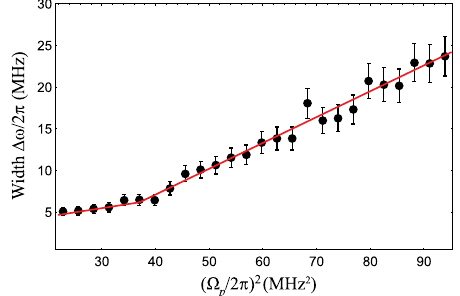
FIG. 9. Width of EIT transmission window vs Ω 2 same data set as in Fig. 4(b) ( n ¼ 47 ). As for the shift in peak transmission Δ (cid:3) , a linear increase can be observed above the phase transition threshold Ω 2 for a modified decay rate Γ